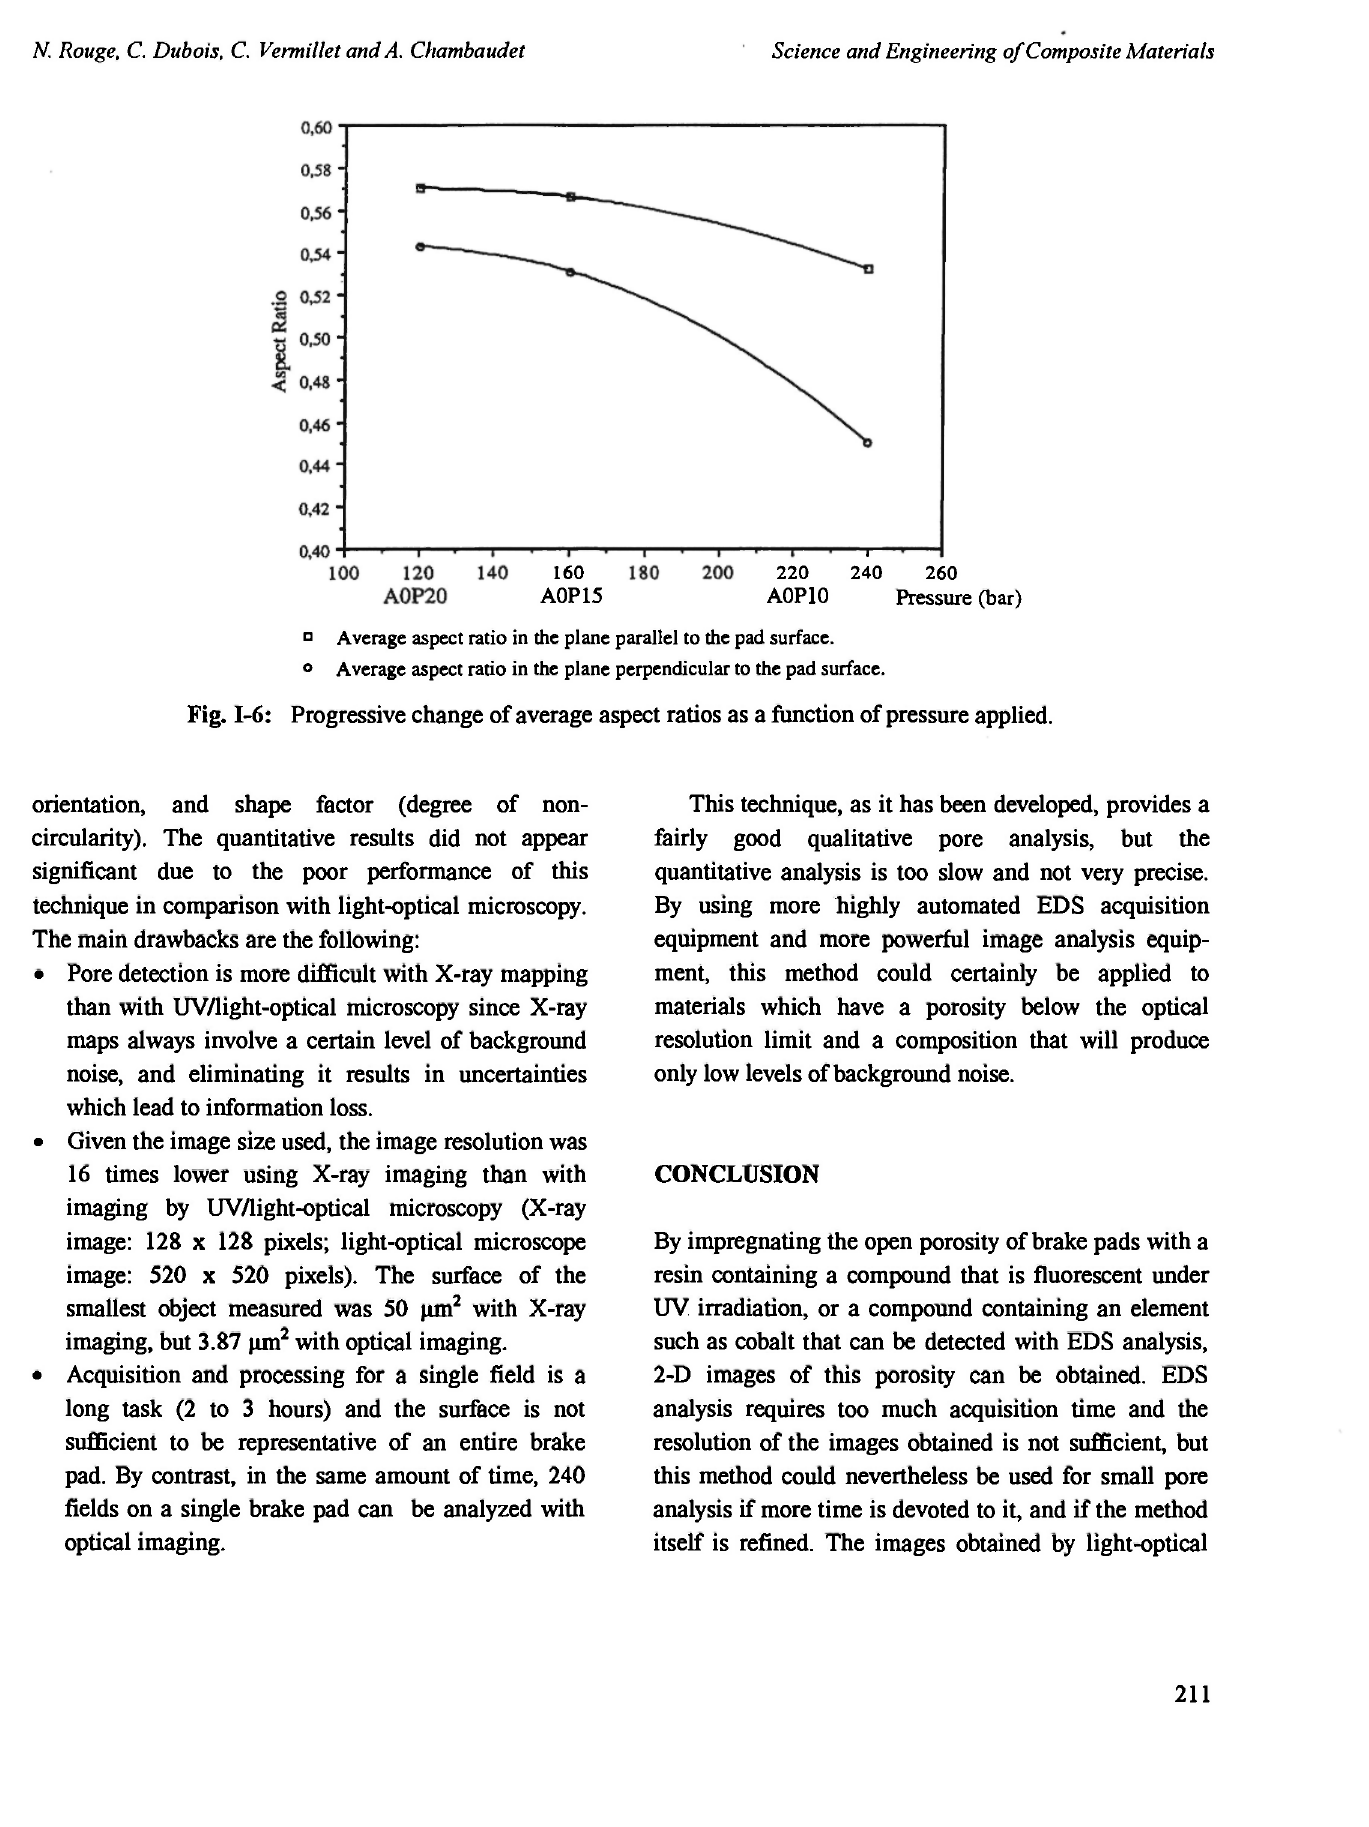
Fig. 1-6: Progressive change of average aspect ratios as a function of pressure applied.